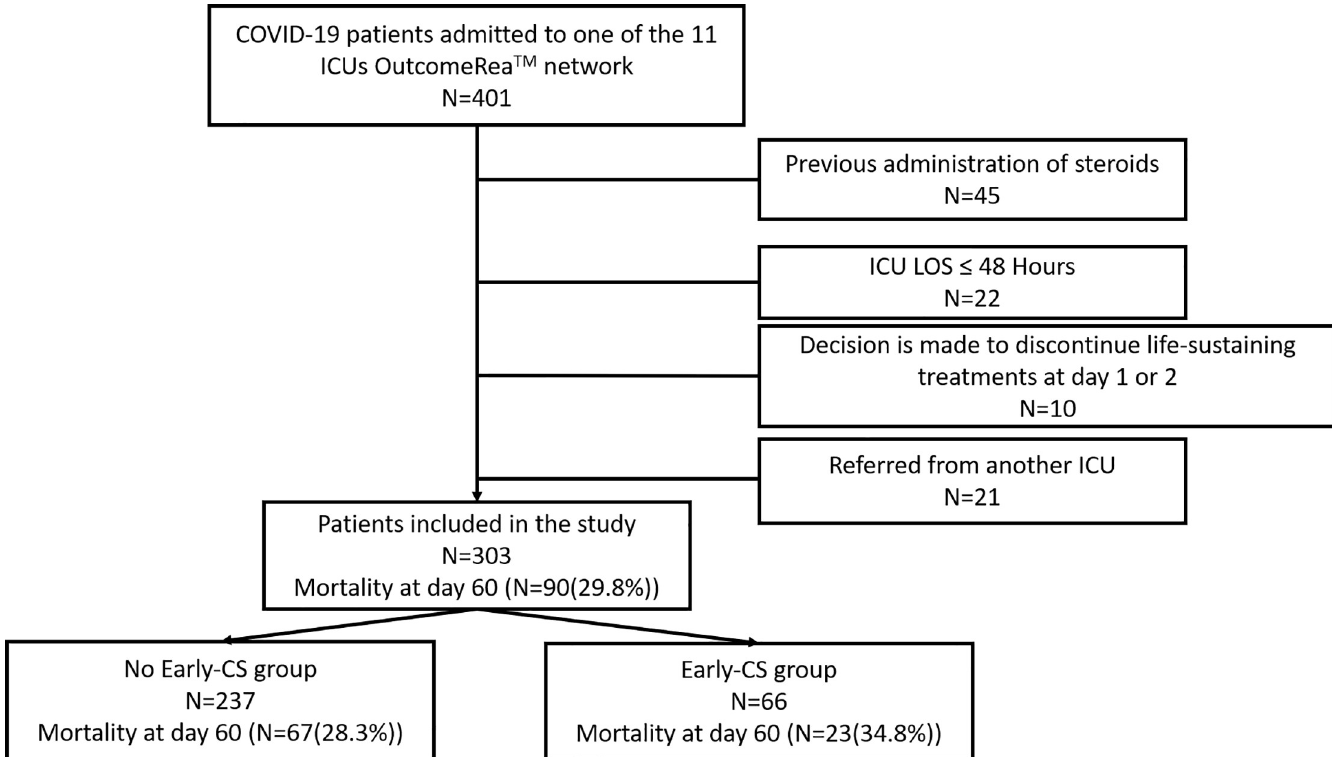
Fig 1. Flow chart. ICU: Intensive care unit; LOS: Length of stay; CS: Corticosteroids.